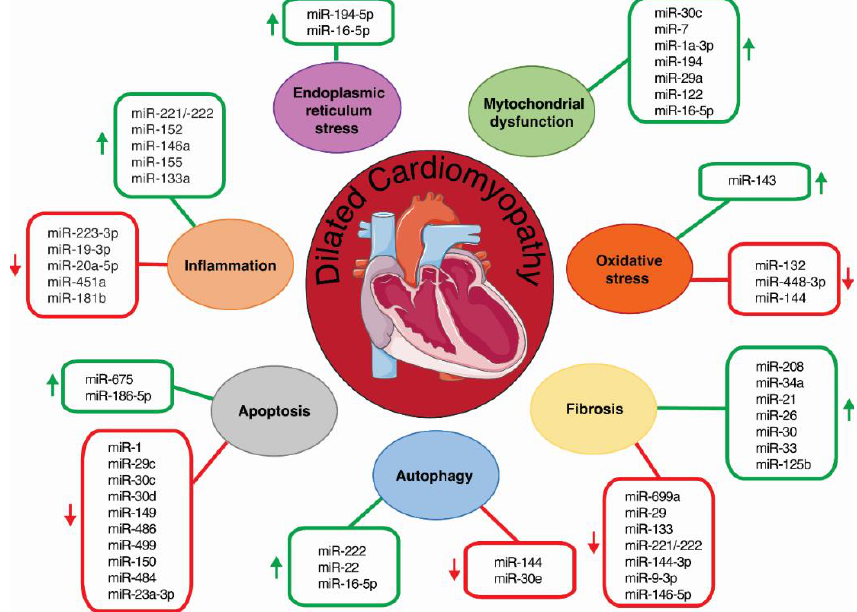
Figure 1. Schematic diagram depicts miRNAs orchestrating distinct mechanisms involved in DCM (inflammation, ER stress, mitochondrial dysfunction, oxidative stress, autophagy, apoptosis and fibrosis). Green and red arrows indicate positive and negative regulation in the disease, respectively.